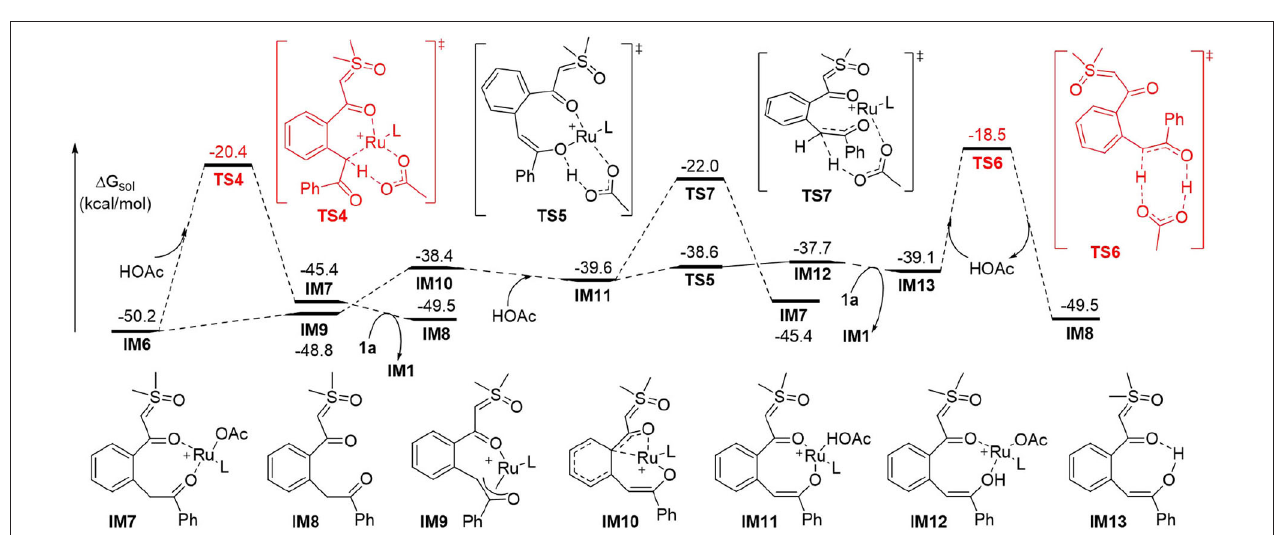
FIGURE 2 | DFT Results for the Generation of the Acylmethylation Intermediate (L = p